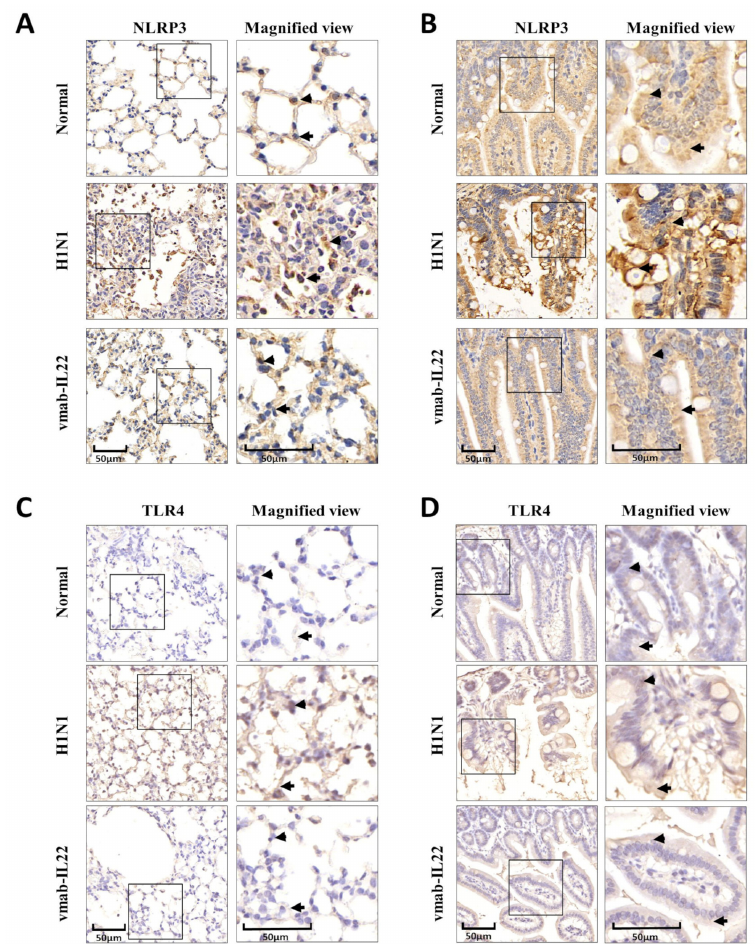
Figure 4. Vmab-mIL22 treatment inhibits the expression of NLRP3 and TLR4 in the lung and small intestine in influenza A virus-infected mice. The infection and treatment schemes were the same as in Figure 1. The expression of NLRP3 ( A , B ) and TLR4 ( C , D ) was assayed using IHC in the lungs and small intestine ( n = 4). Positive cells are indicated by triangles and arrows. NLRP3, NOD-like receptor thermal protein domain associated protein 3; TLR4, toll-like receptor